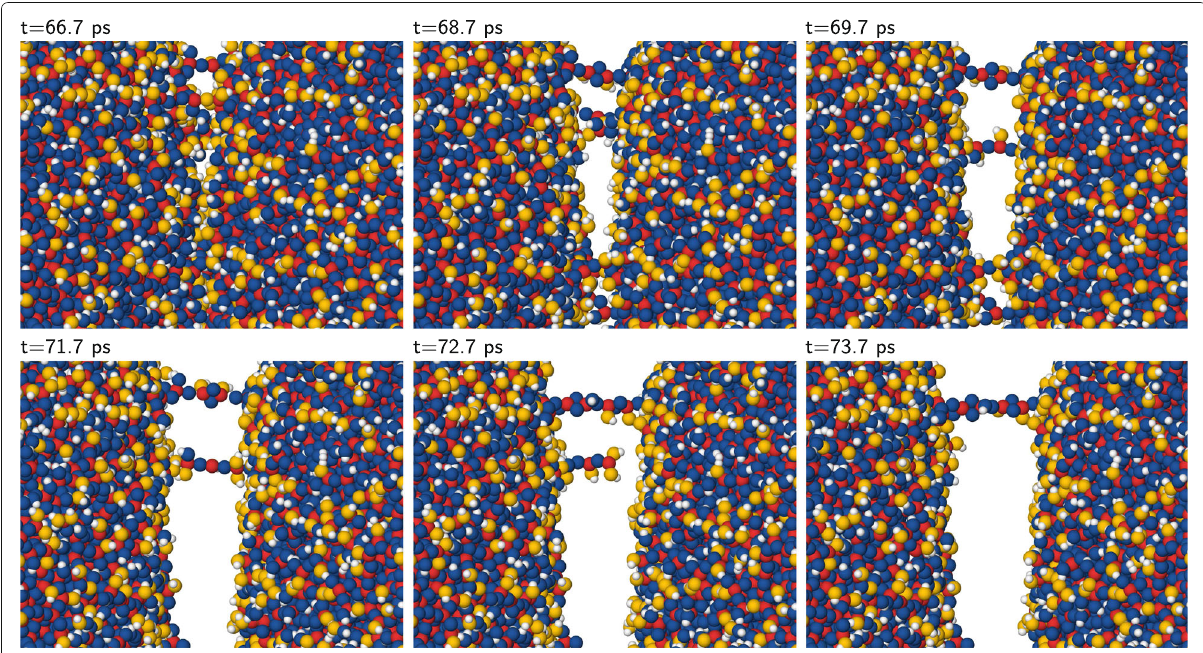
Fig. 4 Series of snapshots. Series of snapshots—times of 66.7–73.7 ps after the collision—showing the formation of temporary filaments between two NPs of radius R = 15 nm after a collision with v = 75 m/s. Color code as in Fig. 1